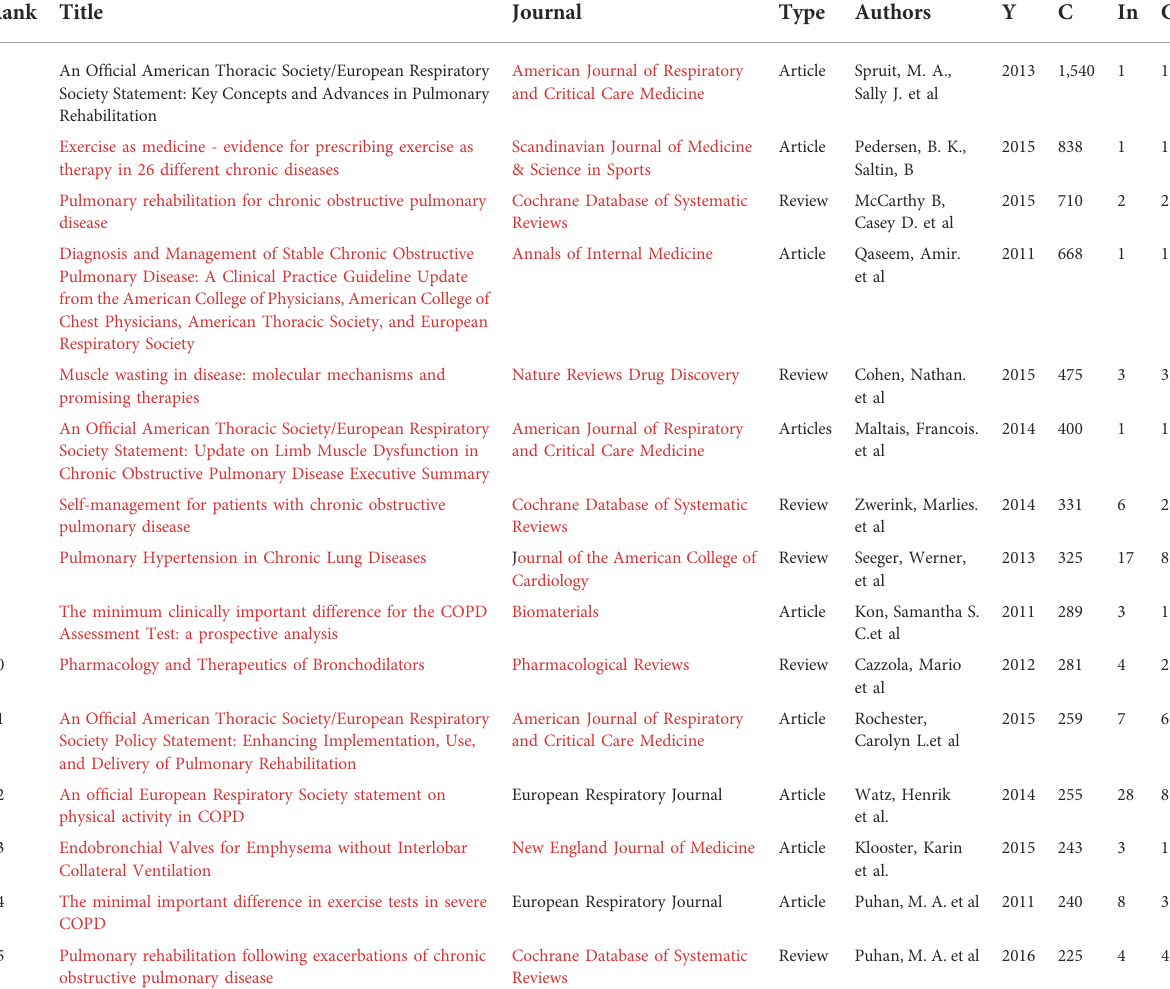
TABLE 6 Top 15 co-cited articles, cited authors and cited